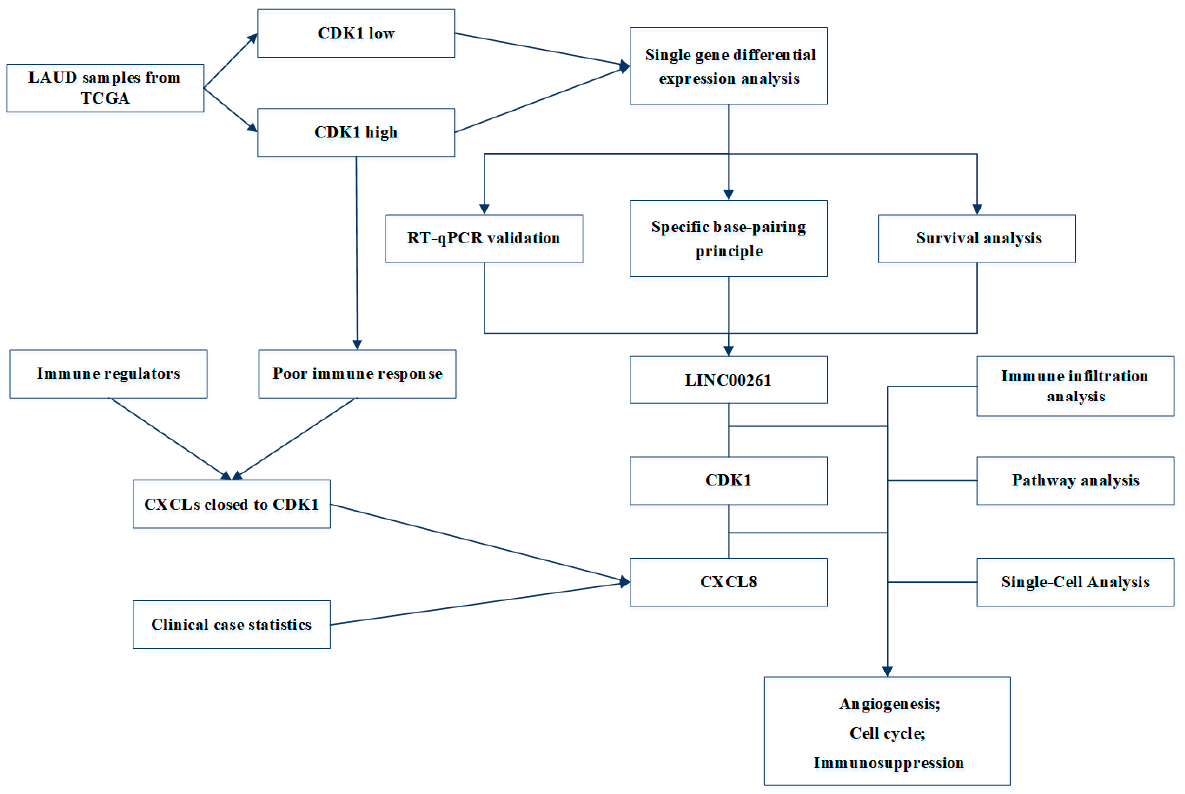
Figure 10. Flowchart of the study.